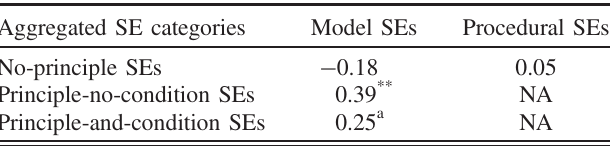
TABLE XII. Correlations between the aggregated SE measures and score on the conceptual test. Note that N ¼ 54 for all correlations.